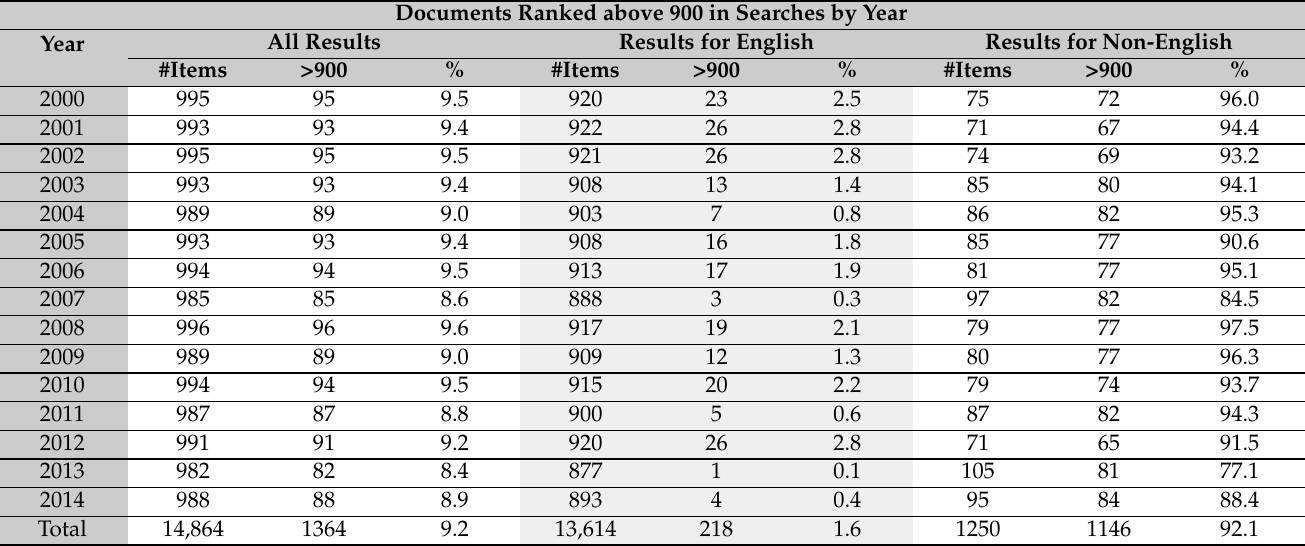
Table 2. Number of documents ranked above 900 in the case of searches by year.